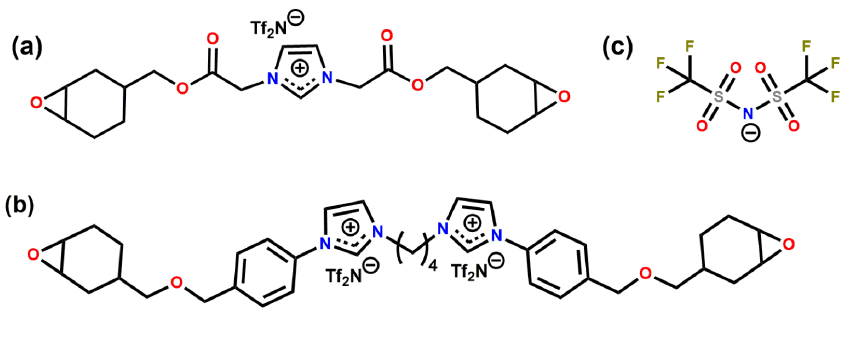
Figure 1. Chemical structures of ( a ) CEIL-2 monomer, ( b ) CEIL-3 monomer and ( c ) Tf 2 N − .